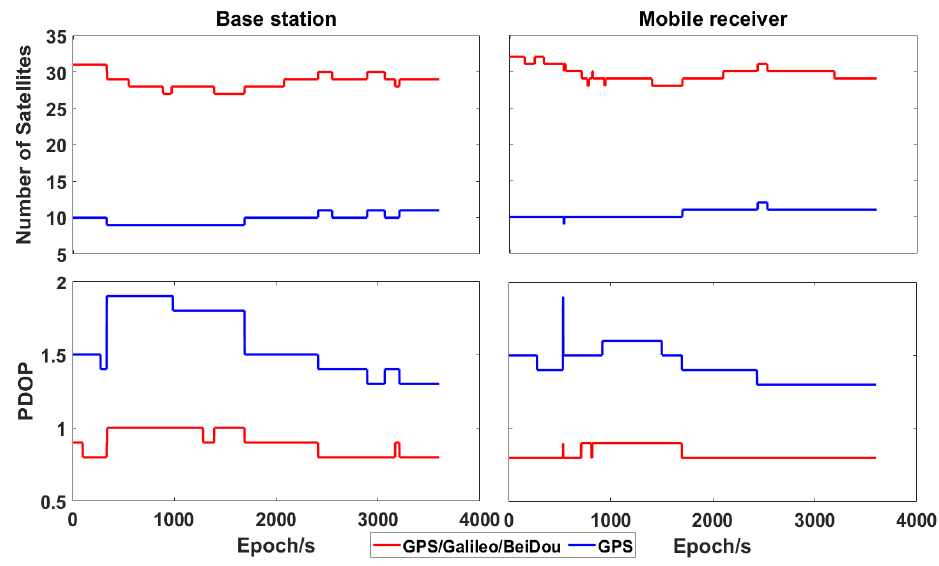
Figure 13. Number of visible satellites and PDOP related to base station and mobile receiver. The SNR and pseudorange multipath (MP1/MP2) at mobile receiver are shown in Figure 14. The severe interferences were observed both for SNR measurements and MP1/MP2 by using GPS, Galileo and BeiDou satellites. These might result from sea sur- face reflection.